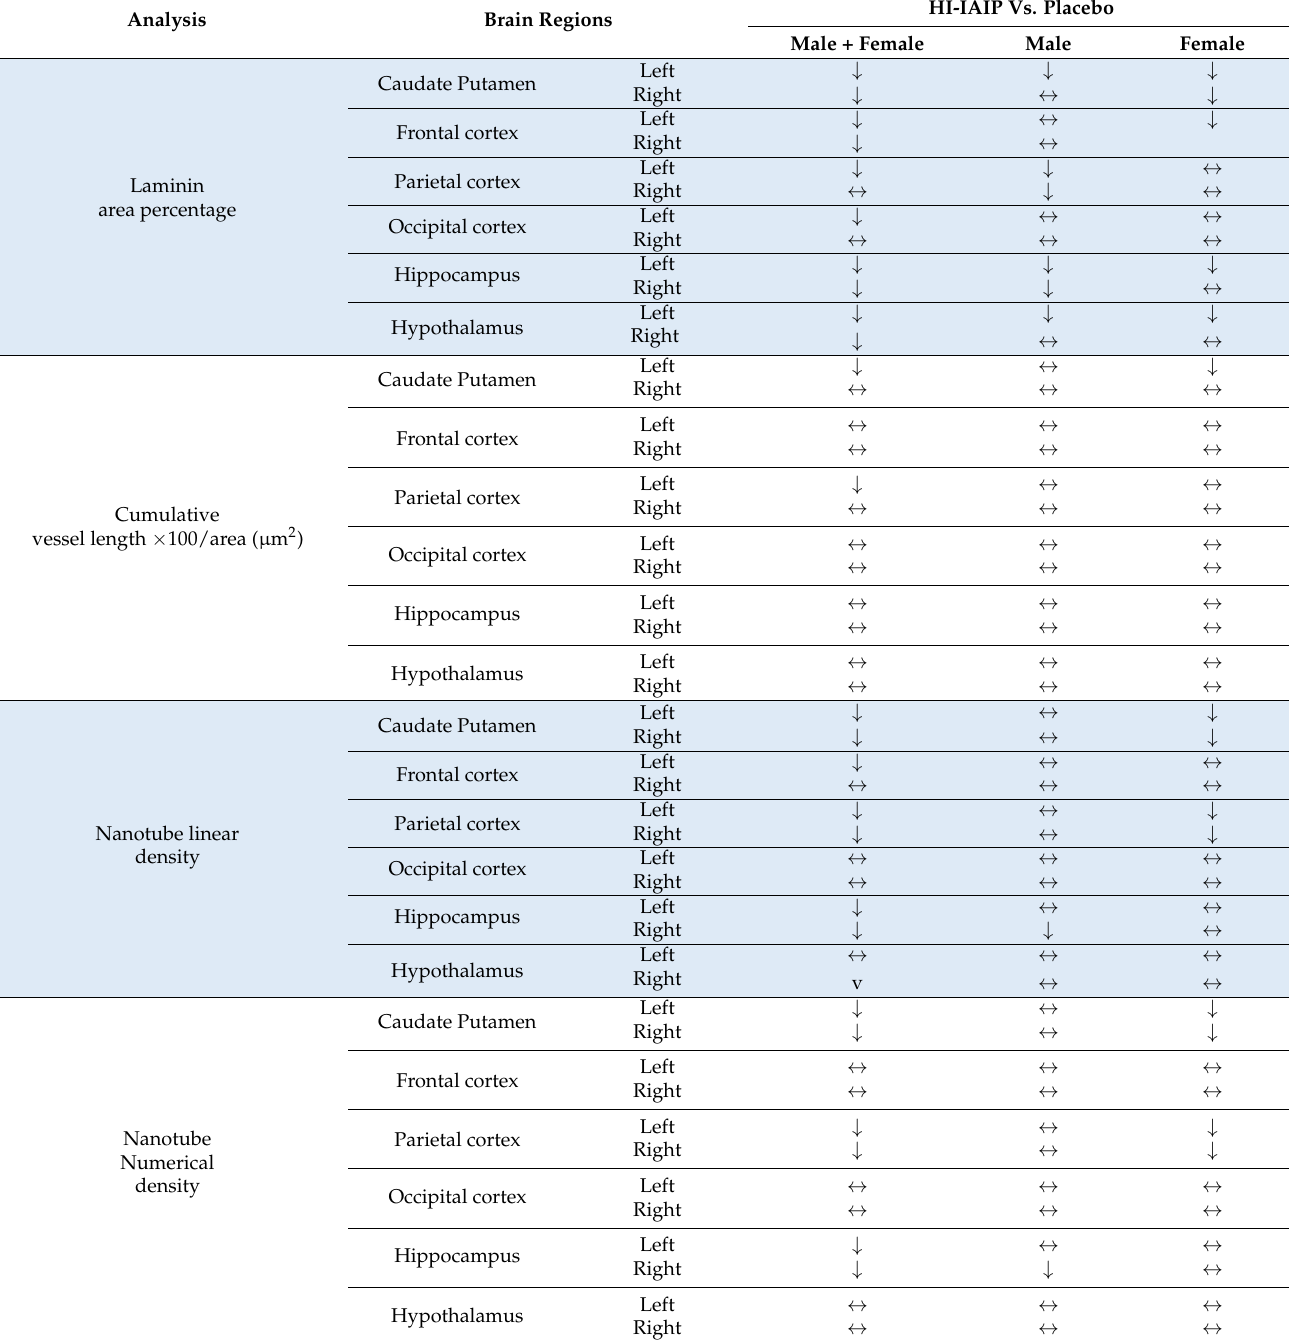
Table 1. Schematic summary of statistically significant/non-significant differences in the quantifica- tion of the chosen morphometric parameters analyzed by laminin immunostaining in hIAIP- and placebo (PL)-treated neonatal rats. ↓ indicates reduced values, whereas ↔ indicates no statistically significant differences. Left: H-left hemisphere. Right: HI-right